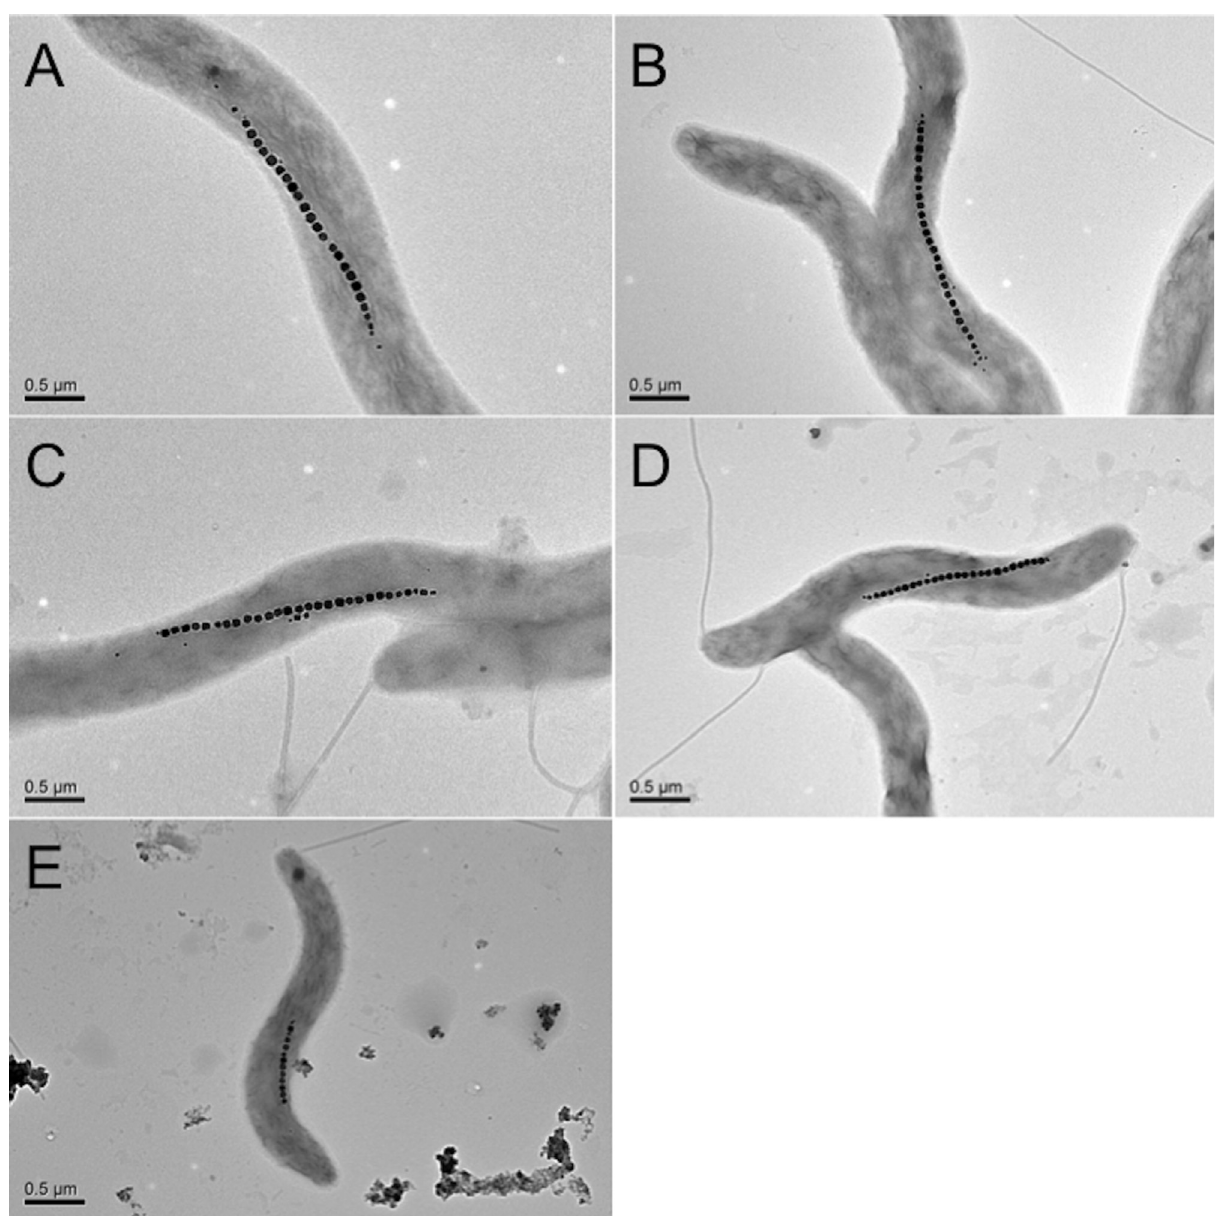
Fig 2. TEM images of magnetosomes synthesized in M . magnetotacticum MS-1 incubated in the culture medium containing PEGs. (A) Magnetosomes synthesized in the absence of PEG; (B), (C), (D), (E) Magnetosomes synthesized in the presence of 0.5% PEG200, 0.5% PEG6,000, 0.5% PEG20,000, and 0.5% PEG500,000. The scale bars represent 0.5 μ m.